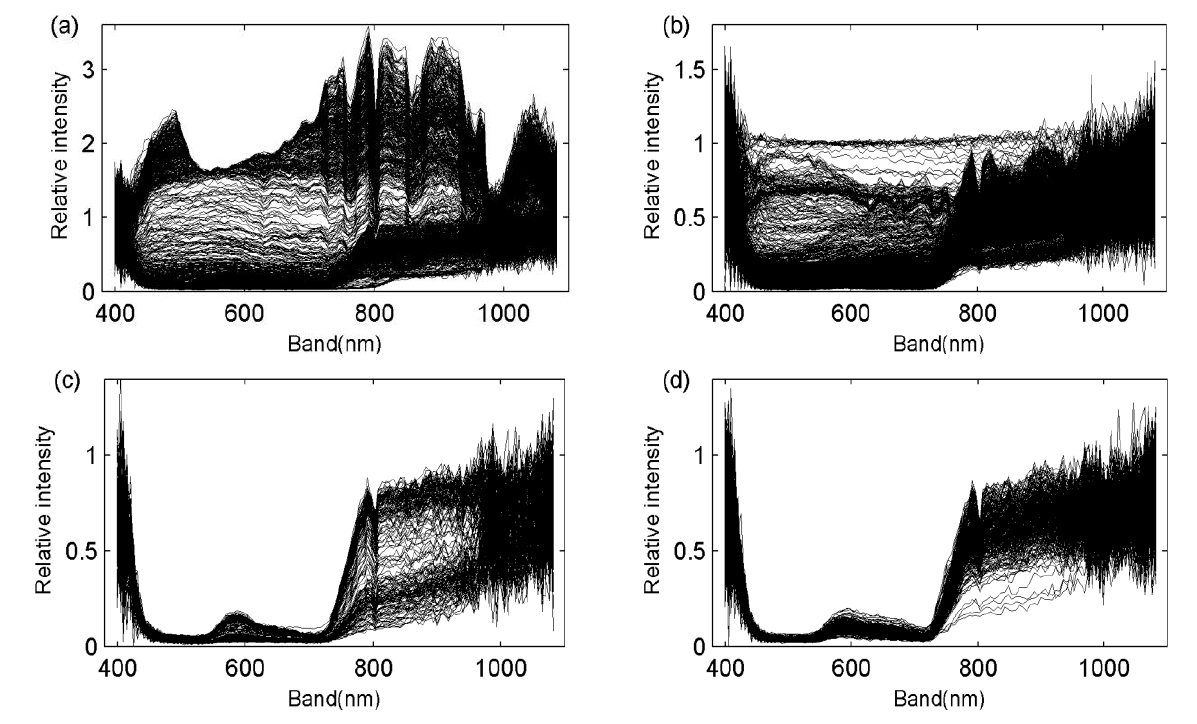
Figure 3. Illustration of the spectra of a tree individually for the species of ( a ) CWB; ( b ) PO; ( c ) CE; and ( d )